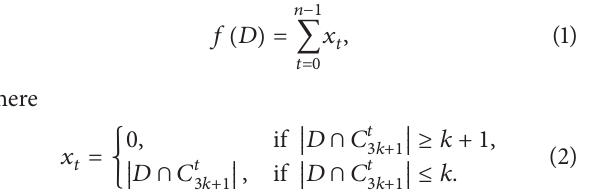
offices, or similar facilities [2]. Dominating sets have also been applied in coding theory [2] and social networks